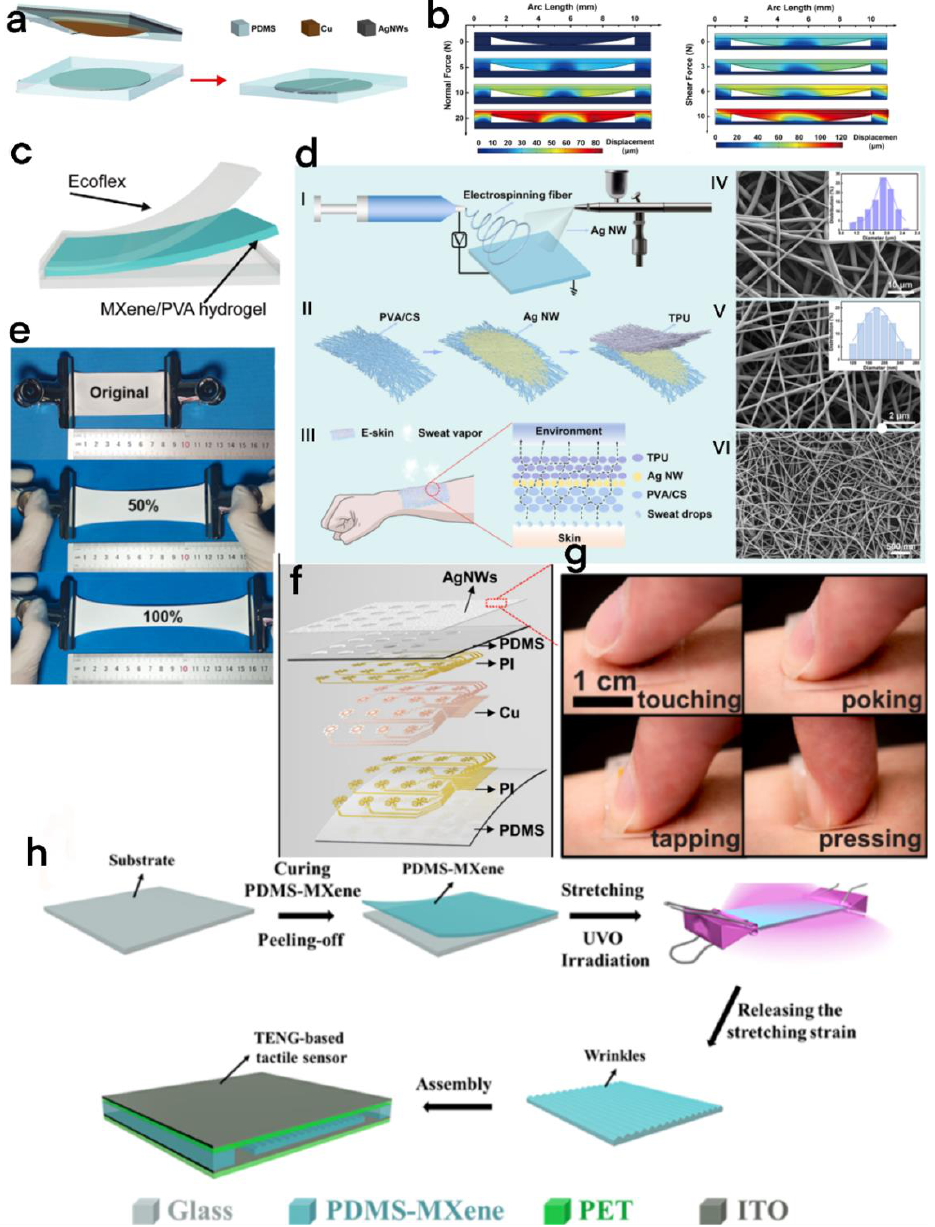
Figure 9. ( a ) Structural diagram of TENG-based electronic skin sensor. ( b ) The left half is the analog sensor displacement plot under the normal force of 0, 5, 10, and 20 N. The right half is the numerical calculation of the sensor ’ s deformation under different shear loads [69]. Wang et al. (2021), ACS. ( c ) Structural diagram of the MH-TENG [70]. Luo et al. (2021), John Wiley and Sons Inc. ( d ) Fabrication and characterization of the E-skin. (I) The fabrication process of the E-skin. (II) Schematic structure of the E-skin. (III) Schematic illustration of the transmission path in the E-skin of sweat on the arm. (IV) The SEM images of the TPU layer. The inset shows the diameter distribution. (V) The SEM images of the PVA/CS layer. The inset shows the diameter distribution. (VI) The SEM image of the Ag NW electrode layer.( e ) Picture of electronic skin elongation test [71]. Shi et al. (2021), ACS. ( f ) Some 4 × 4 schematic diagrams of the sensor array. ( g ) Touch, poke, tap, and press with your fingers [72]. He et al. (2021), Elsevier. ( h ) Triboelectric tactile sensor based on pleated PDMS/MXene composite film [73]. Cai et al. (2021), Elsevier.